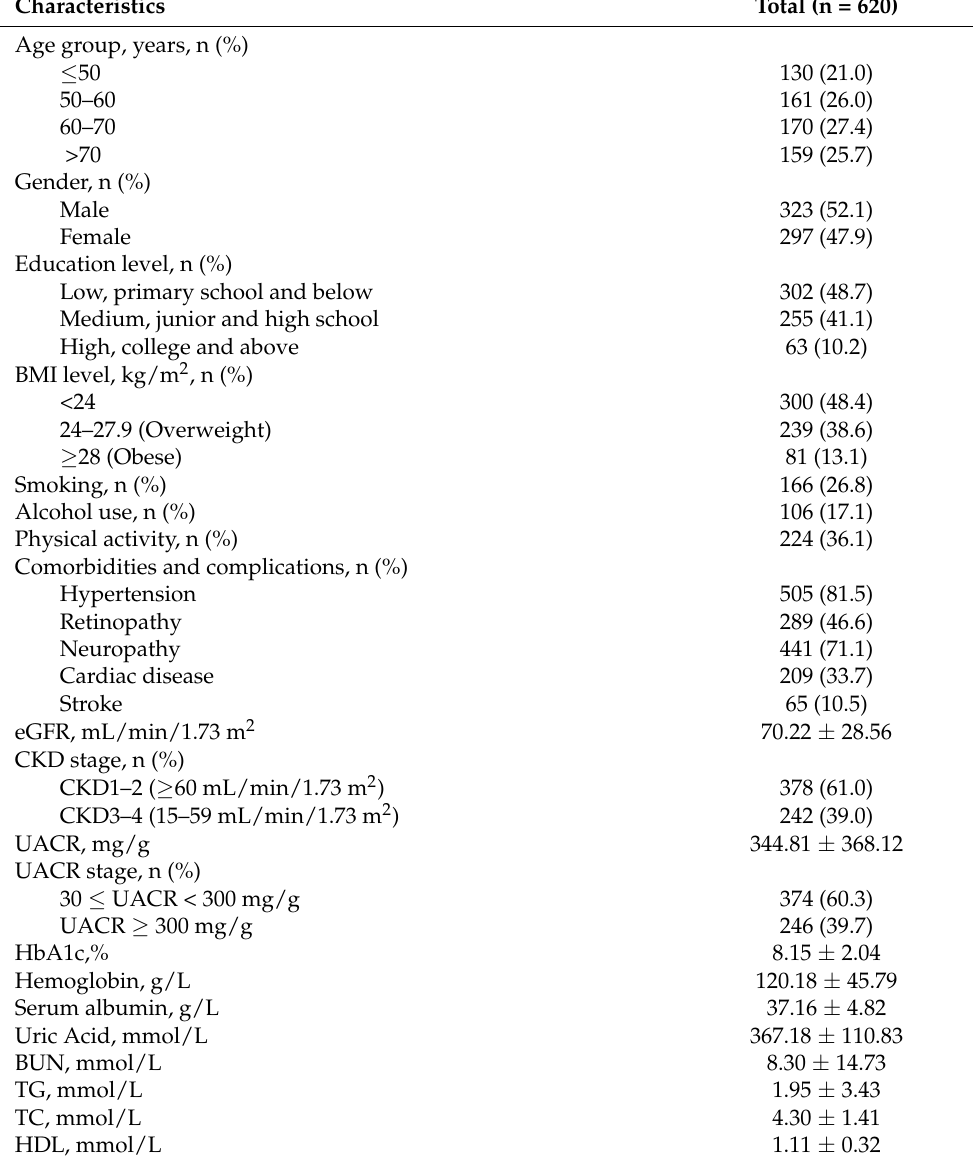
Table 1. Socio–demographic and clinical characteristics of the participants (n = 620).